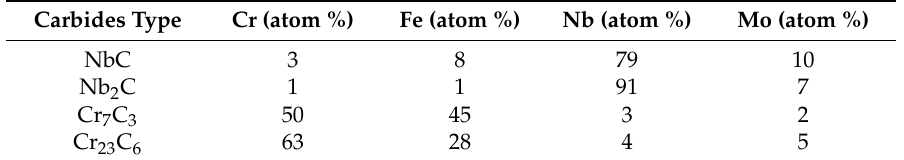
Table 6. EDS measurements: Average atomic fractions of metals present in the extracted carbides.